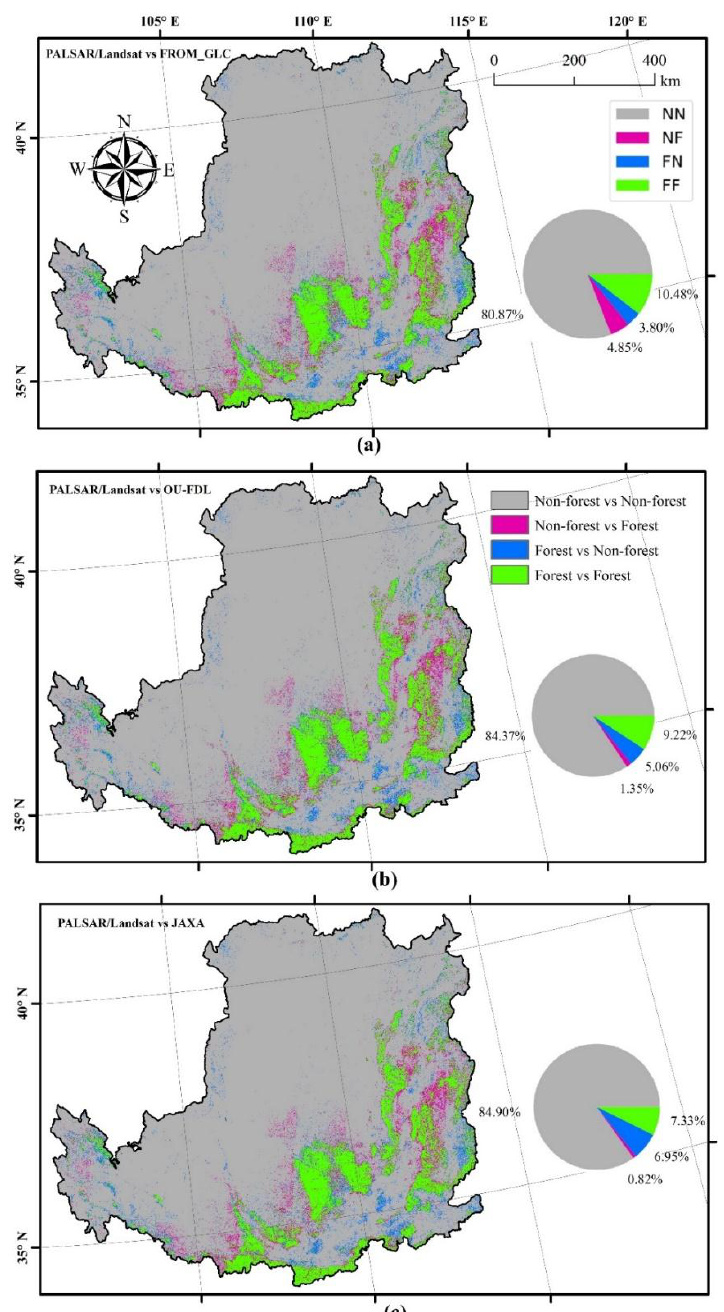
Figure 8. Spatial comparison between the PALSAR / Landsat forest map and ( a ) FORM-GLC forest map, ( b ) JAXA forest map, and ( c ) OU-FDL forest map.